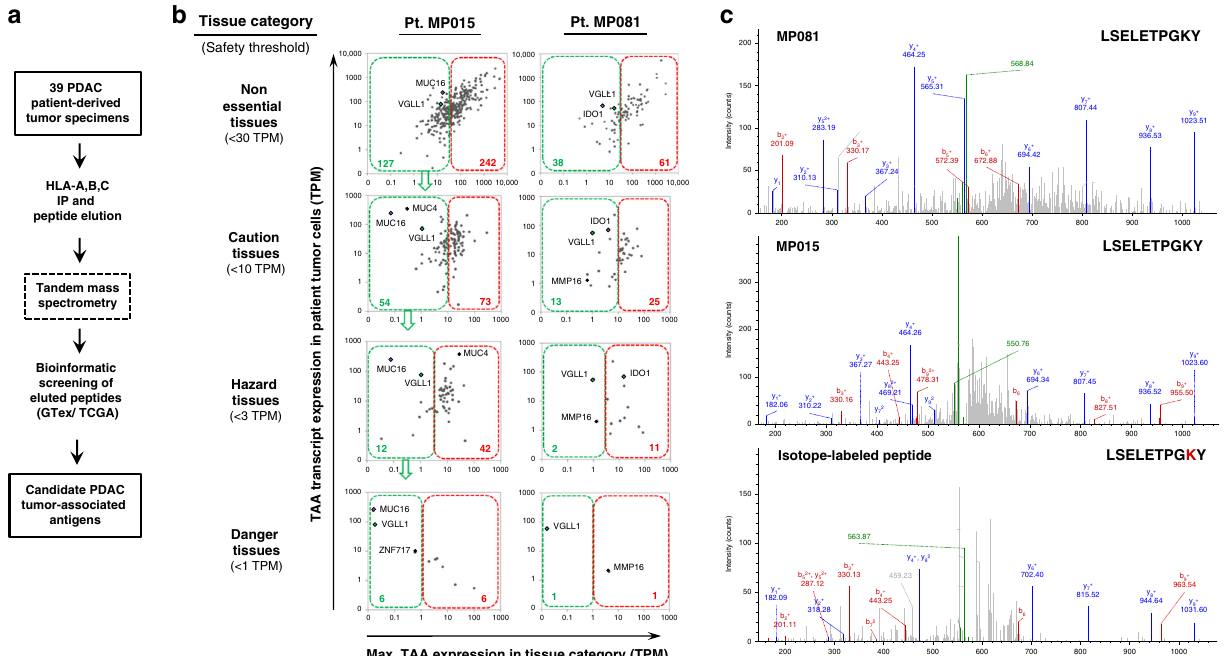
Fig. 1 Immunopeptidome analysis reveals a VGLL1-derived peptide expressed by two PDAC patient-derived organoid lines. a Experimental strategy to identify PDAC tumor-speci fi c, HLA class I-bound peptides from 39 tumor specimens derived from 35 M.D. Anderson PDAC patients. b Bioinformatics screening strategy to identify potentially targetable TAAs from amongst the eluted PDAC-associated peptides. Peptide-encoding genes were assessed for PDAC tumor RNAseq expression compared with transcript expression in 53 GTex Portal normal tissues. Excluding testis, normal tissues were separated into four categories (non-essential, caution, hazard, and danger tissues) that re fl ected the potential toxicities expected from off-tumor killing activity against different tissues (listed in Table S2). All peptide-encoding genes were fi ltered successively using four corresponding expression thresholds of increasing stringency (30, 10, 3, and 1 TPM, indicated by green dotted lines) to eliminate candidate TAAs most likely to elicit autoimmune toxicity in the context of CTL therapy (red dotted lines). Screening of high-con fi dence peptides isolated from tumor organoid cell lines of PDAC patients MP015 and MP081 is depicted, showing that few eluted peptides met these stringent criteria. c Mass spectra of an HLA-A*0101-restricted VGLL1-derived peptide isolated from two different PDAC organoid cell lines, MP015 and MP081 (top 2 panels). The patient-derived peptides co-eluted with and matched the MS fragmentation spectra of the synthetic isotope-labeled VGLL1 peptide LSELETPGKY (containing a 13 C/ 15 N-labeled lysine residue), with the labeled y + fragment ion series (shown in blue) demonstrating an expected shift of 8 atomic mass units, unlike the b + fragment ions (bottom panel). IP immunoprecipitation, TPM transcripts per million, TAA tumor-associated